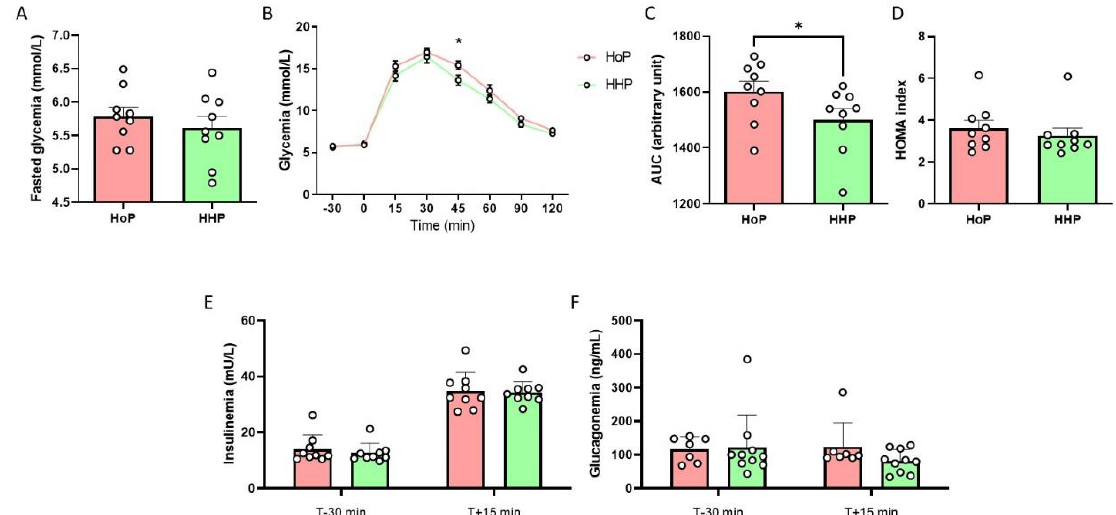
Figure 3. A chronic oral HHP-BM treatment improves glucose tolerance in adult mice. Oral Glucose Tolerance Test (OGTT) in fasted mice after an oral administration of HoP- or HHP-BM (100 µL/day during one week; n = 9 per group). ( A ) Fasted glycemia, ( B ) Glycemia during OGTT and the area under the curve (AUC) ( C ) and HOMA index ( D ), plasma insulin ( E ) and glucagon levels ( F ). * p < 0.05 compared to mice treated with HoP-BM.